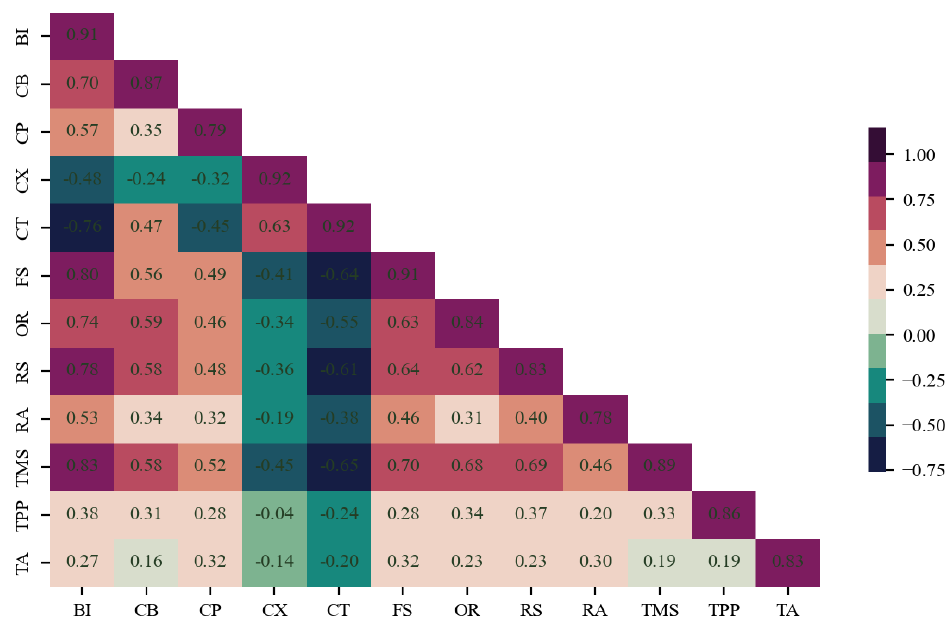
Figure 2. Fornell and Larcker criterion for discriminant validity results.